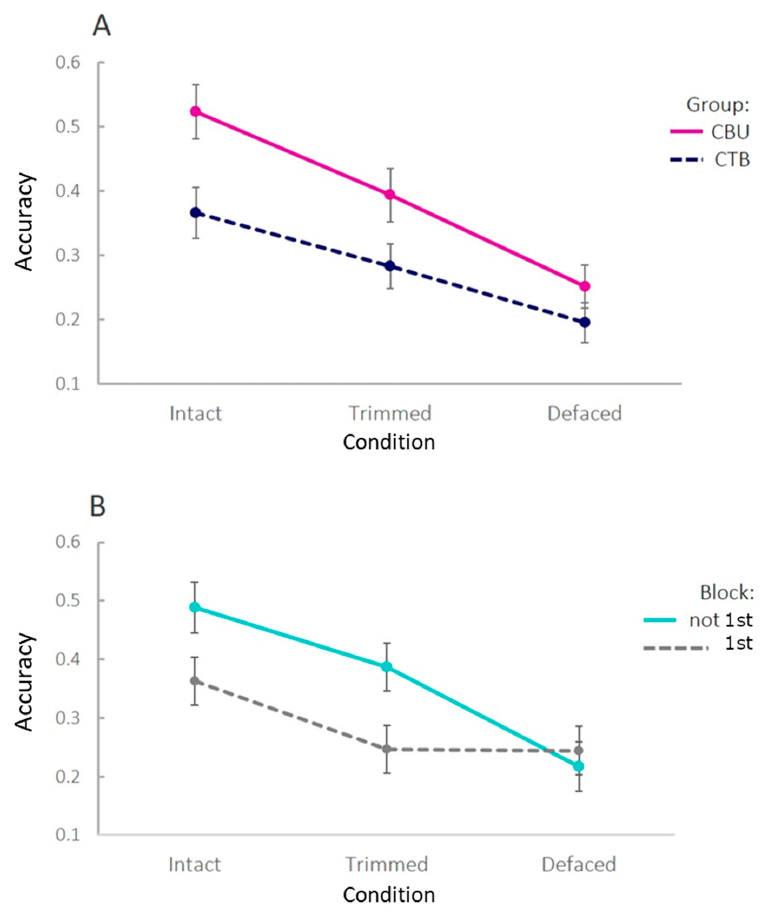
Figure 2. Identification accuracy as function of Condition and Participant Group (Panel ( A )) or whether the condition was run as the first block or not (Panel ( B